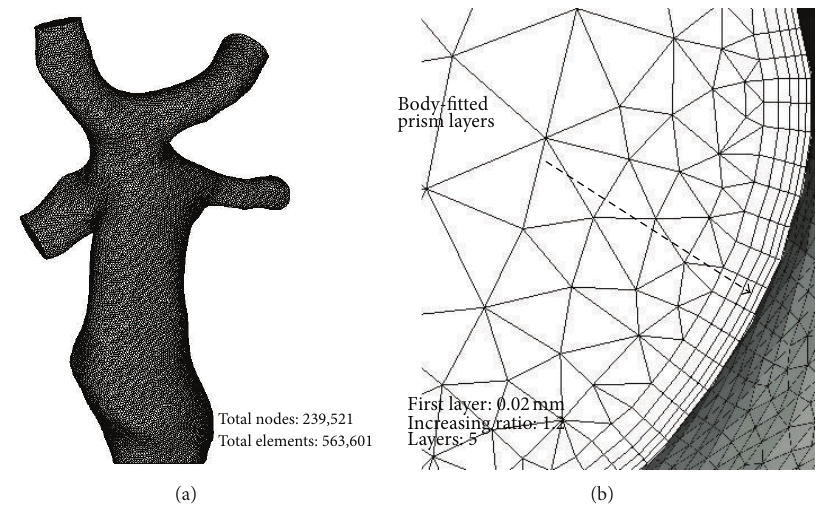
Figure 4: Mesh information. (a) Calculation domain with grids. (b) Body-fitted prism layers.